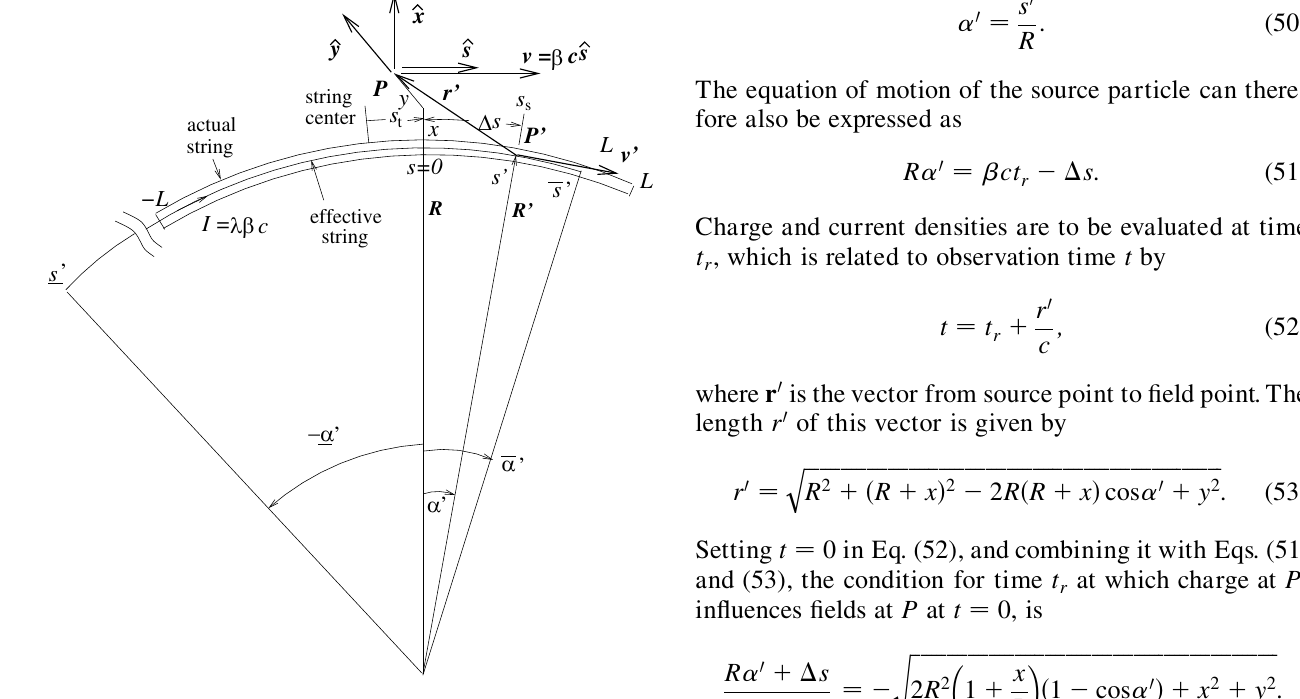
FIG. 6. Definition of coordinates. A snapshot of the present, actual, charge distribution is shown, and superimposed on it is an electrostatic/magnetostatic configuration equivalent to the true electrodynamic system of a moving charged string. There are moving charges in just those locations of charges in the true system that, at some earlier time t < 0 , contribute to fields at P at t (cid:1) 0